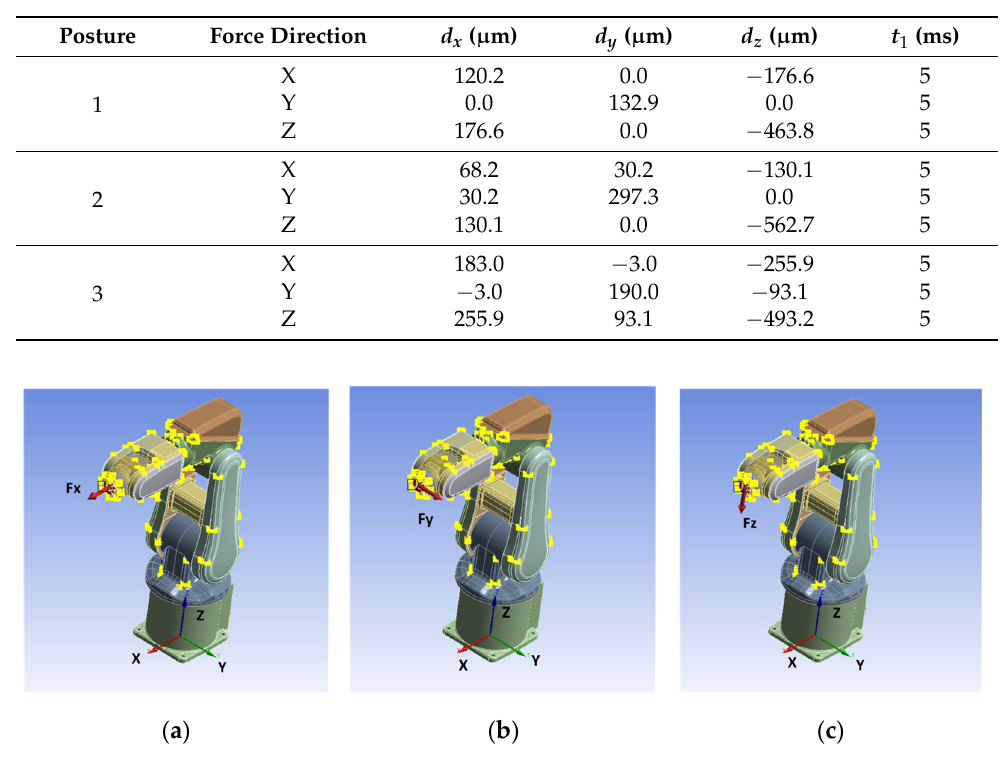
Figure 4. The applied forces at the center of the robot’s EE: ( a ) along the X-direction; ( b ) along the Y-direction; ( c ) along the Z-direction. Table 8. The deformations of the robot’s EE caused by forces based on the FEA method.